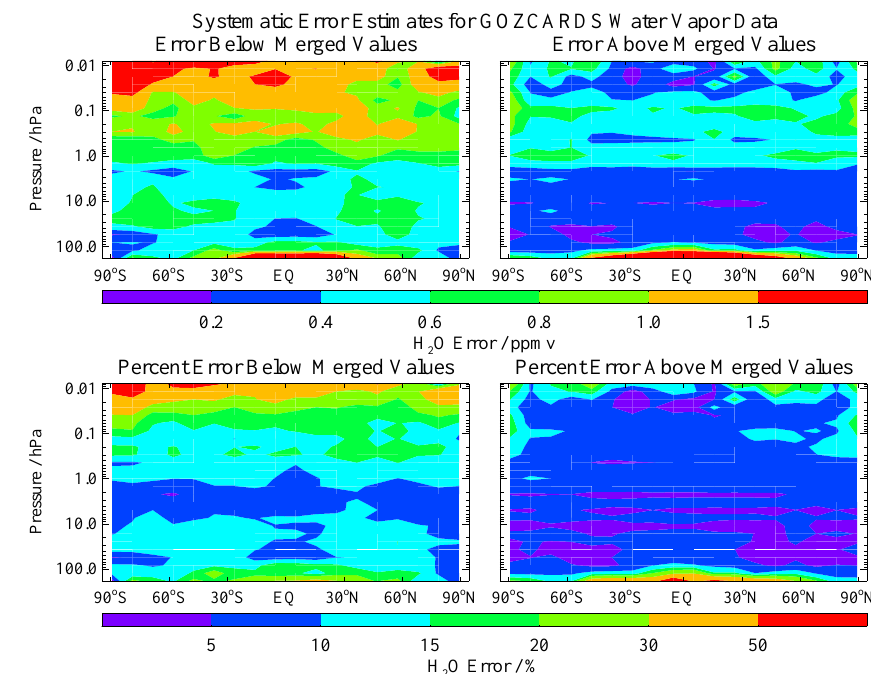
Figure 13. Systematic error estimates for GOZCARDS H 2 O (similar to Fig. 6 for HCl).